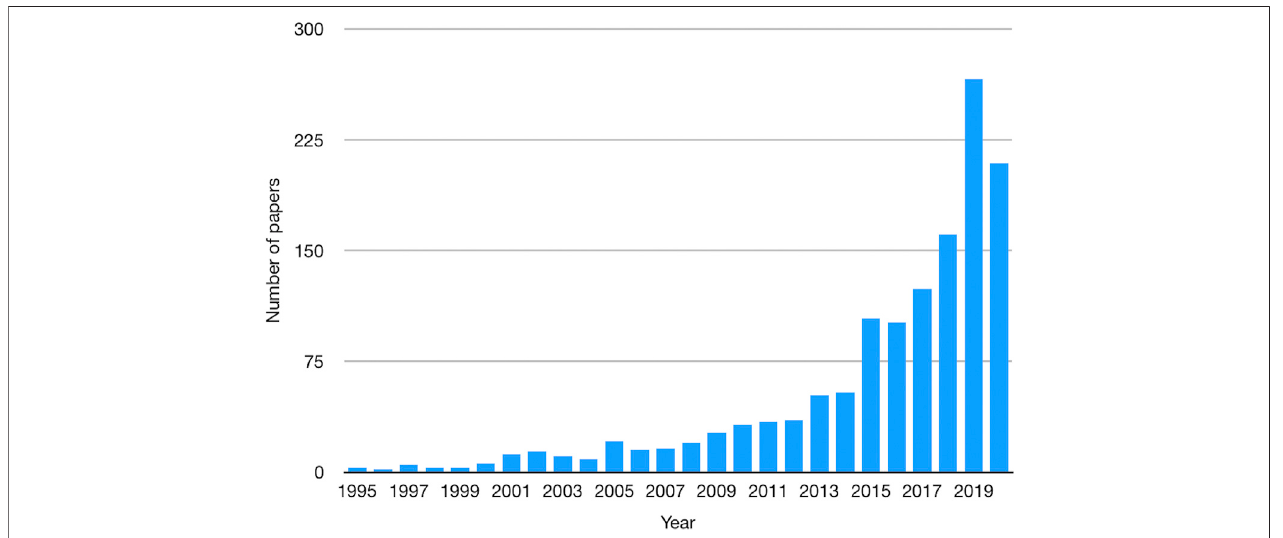
FIGURE 3 | Division of the 1,408 papers, that remained after screening, according to published year.